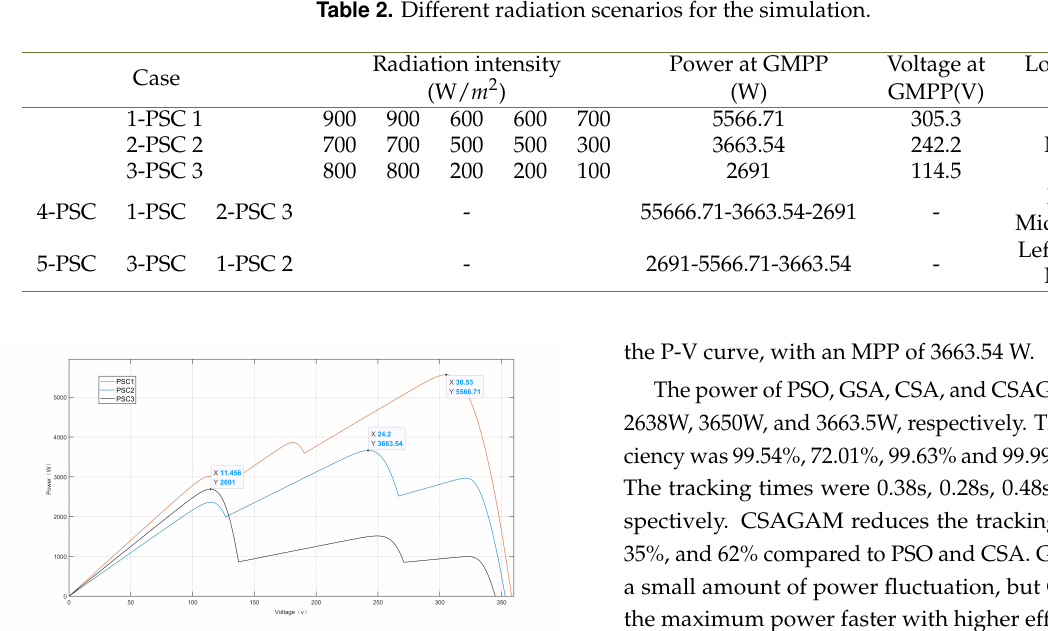
Table 2. Different radiation scenarios for the simulation.